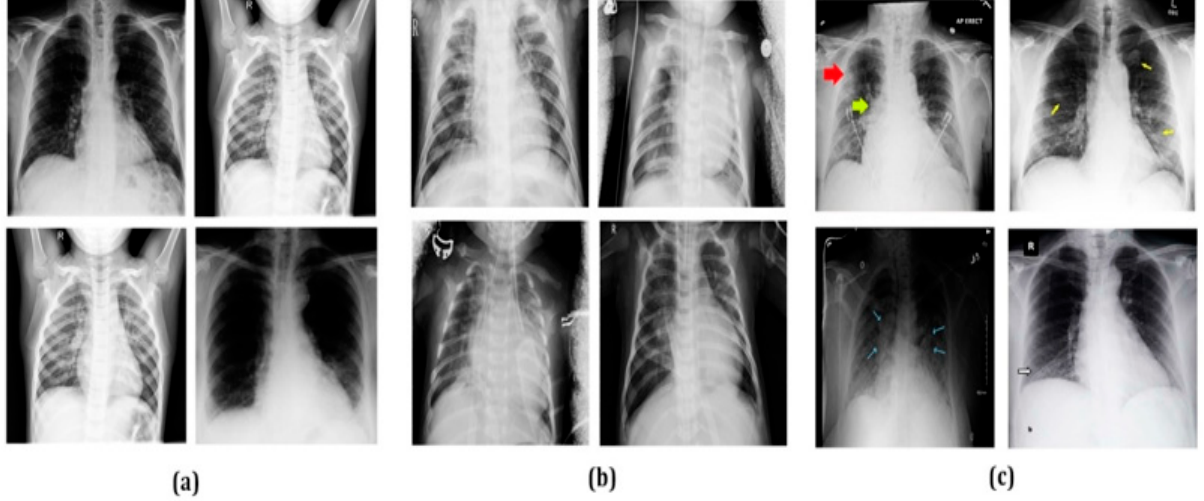
Figure 1. Sample X-ray images of chests of 12 patients: ( a ) normal chests, ( b ) chests with pneumonia, and ( c ) chests infected by COVID-19.